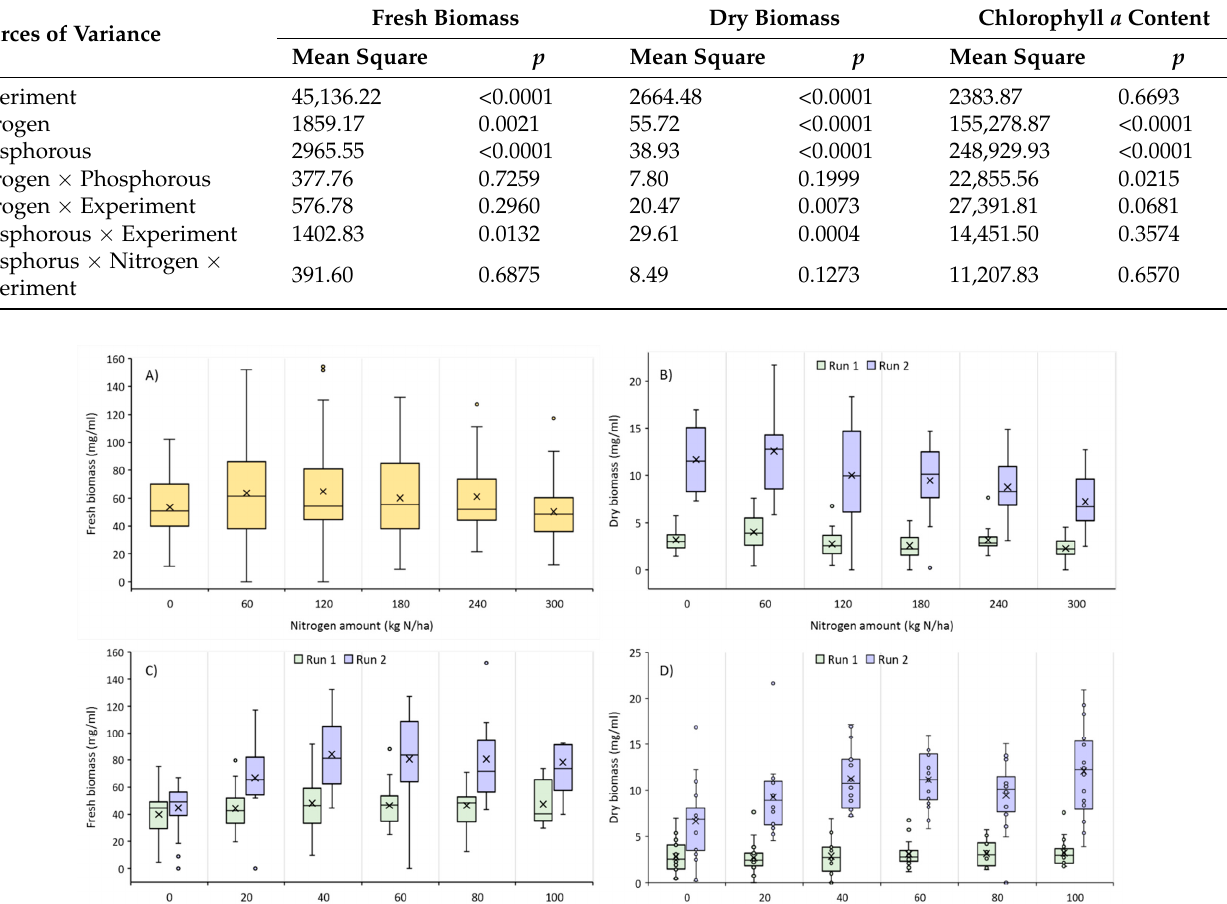
Table 2. Analysis of variance for the effect of fertilizer application rates on total fresh biomass, total dry biomass and water chlorophyll a content.